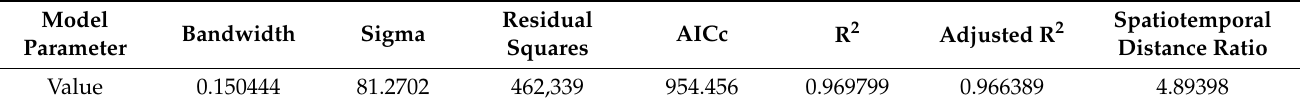
Table 6. Related parameters of